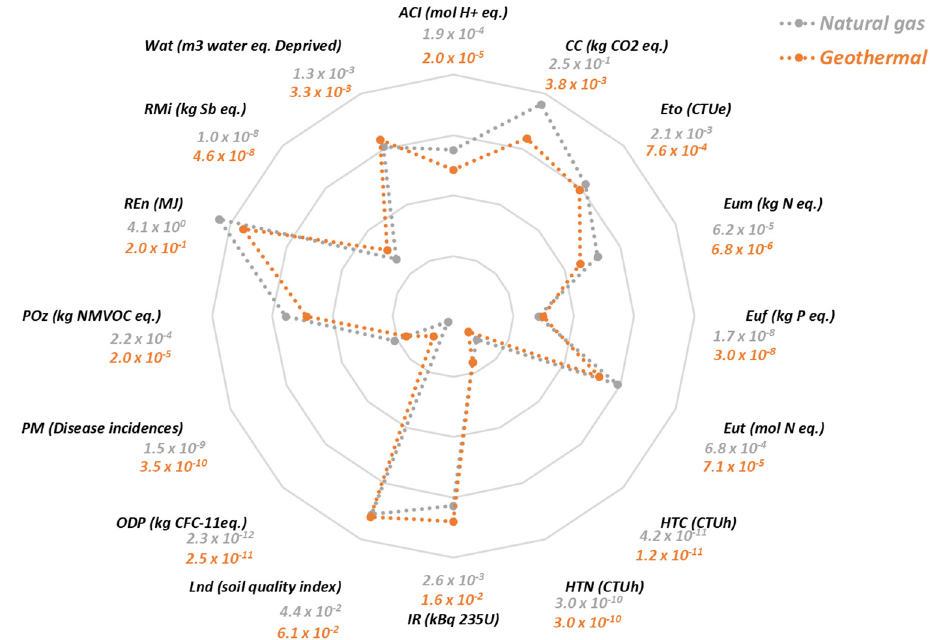
Figure 4. Comparison of the production of 1 kWh th from the most common heat source in Europe (Natural gas, grey dots in Figure 4) with the investigated heat production from the Rittershoffen power plant (Geothermal, orange dots in Figure 4). The characterized results of impacts from natural gas (in grey) and geothermal (in orange) are reported below the corresponding categories. Geothermal source type: liquid, energy conversion technology: direct heat use, load factor: 77%, annual energy output decay: <0.1%, lifetime installation: 30 years, installed capacity: 27 MW th , number of wells: 2 (GRT-1: 2580 m MD, GRT-2: 3938 m total drilled).